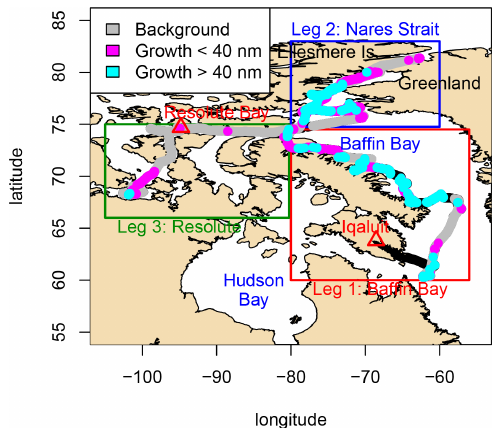
Figure 1. Track of the NETCARE ship cruise (black and coloured points). Rectangles show the three legs and red triangles denote communities. The colour of the points shows times used in calcula- tions of background (grey) and growth > 40nm (light blue). Addi- tional times included in the UFP and growth calculations are shown in